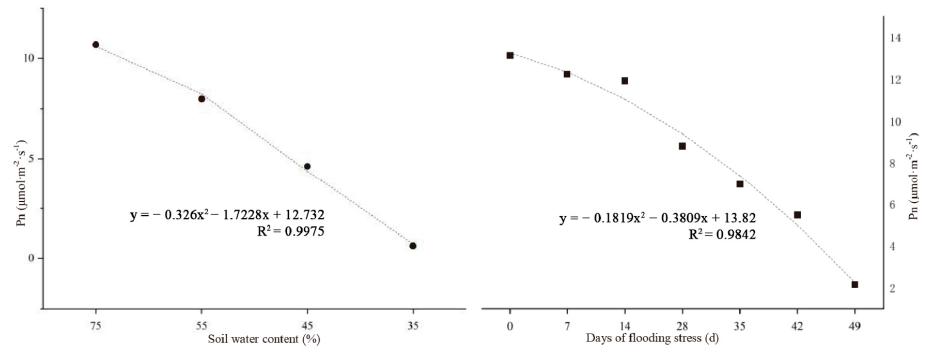
Figure 6. Effect of water stress on the net photosynthetic rate of C. retusus leaves.